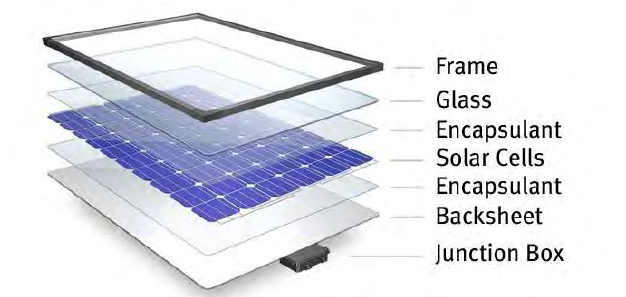
Figure 3. solarcell components (”Australian Business Council for Sustainability Energy”, 2004)